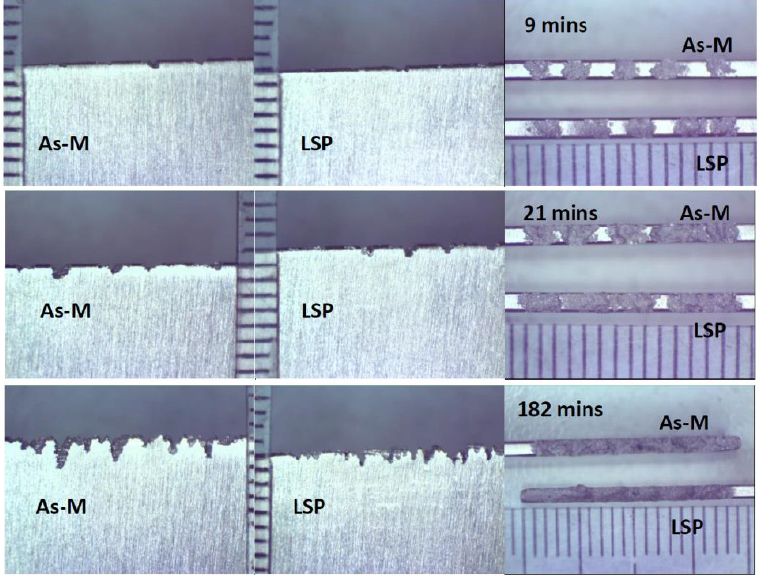
Figure 15. Optical macrographs showing the erosion evolution and progression on As-M and LSP airfoil samples at 350 m/s using 460 μ m.